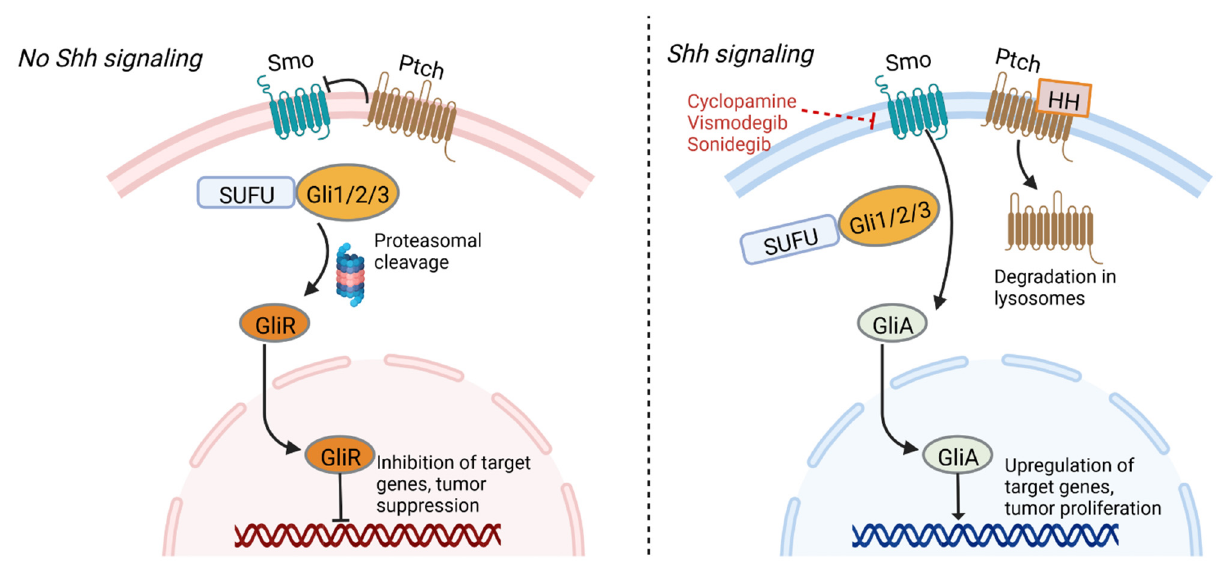
Figure 1. Sonic hedgehog signaling pathway. In the absence of hedgehog ligand, Ptch inhibits Smo, resulting in formation of Gli repressor that inhibits target genes. Ptch and SUFU function as tumor suppressors. Hedgehog ligand’s interaction with Ptch results in its degradation, allowing a signaling cascade mediated by Smo that forms GliA. This transcription factor activates genes associated with tumor proliferation. Inhibitors of Smo represent a potential therapeutic target against GSCs.